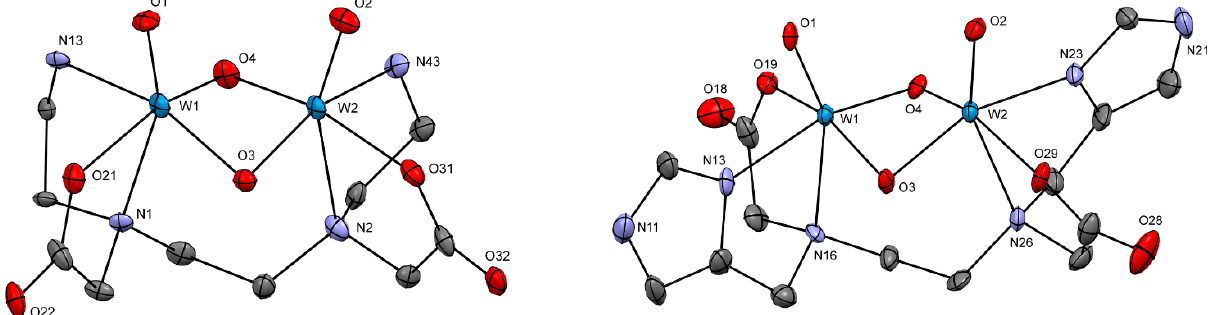
Figure 5. ORTEP view of complexes 2a ( left ) and 3 ( right ) with atom labeling scheme. The thermal ellipsoids have been drawn at 50% probability level. Hydrogen atoms as well as solvent molecules are omitted for clarity.